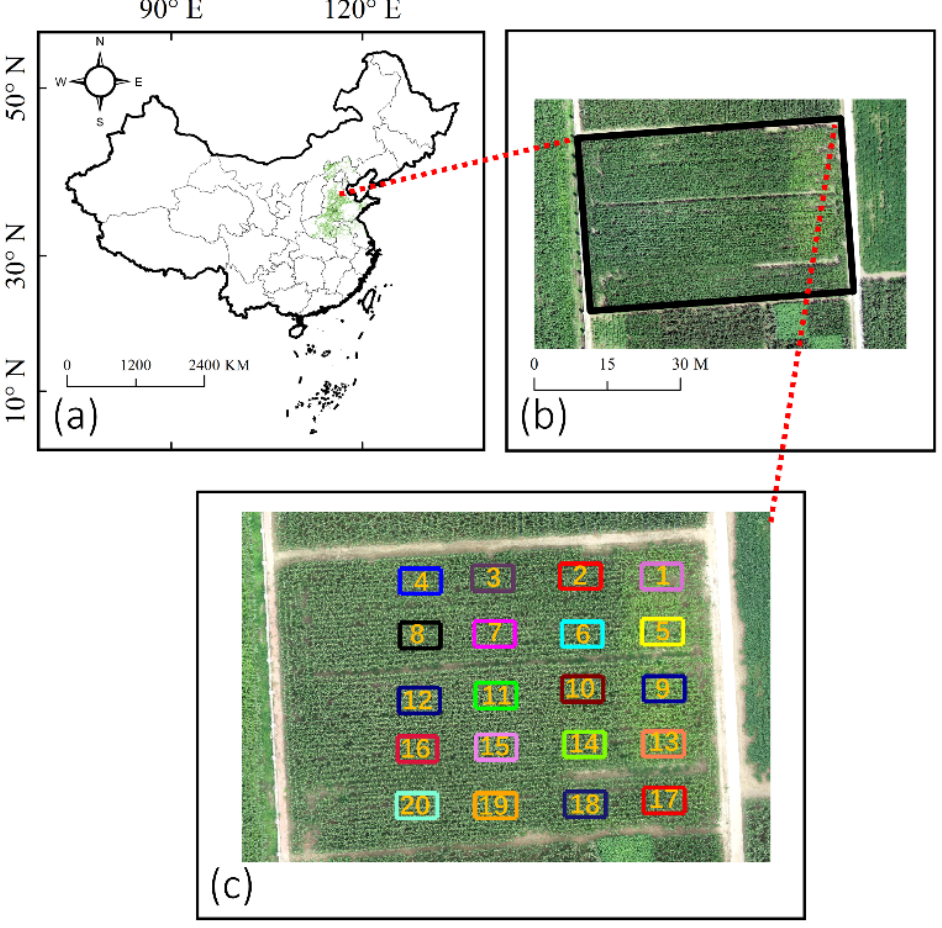
Figure 1. The geo-location of the Nanpi Eco-Agricultural Experimental Station (NEES) and the detailed setting of 20 plots with different treatments of fertilizers. ( a ) the geographical location of experimental station, ( b ) the study area from UAV view, ( c ) the 20 plots for image clipping. In this study, a DJI Phantom 4 Pro V2.0 was applied for collecting RGB images, and a Mini MCA 6 Camera (MMC) mounted on a DJI M600 Pro UAV platform was conducted to collect multispectral images (Figure 2). The detailed information of the cameras and the deployment of data collection were introduced in previous studies [7,14,26].